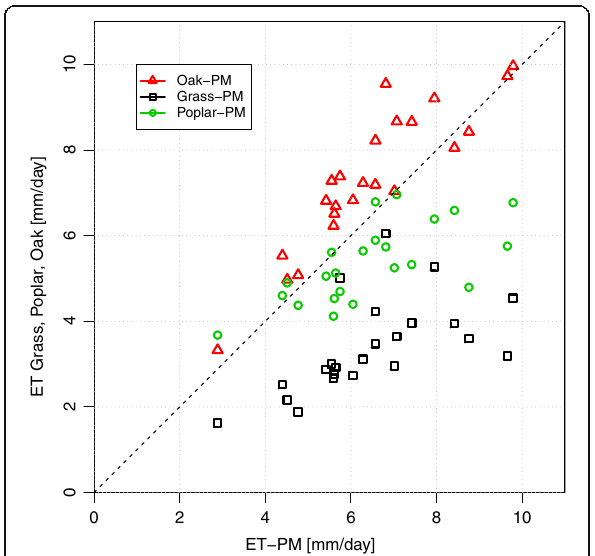
Fig. 7 ET rates of different surface covers compared to Pennman- Monteith ET (ET_PM)